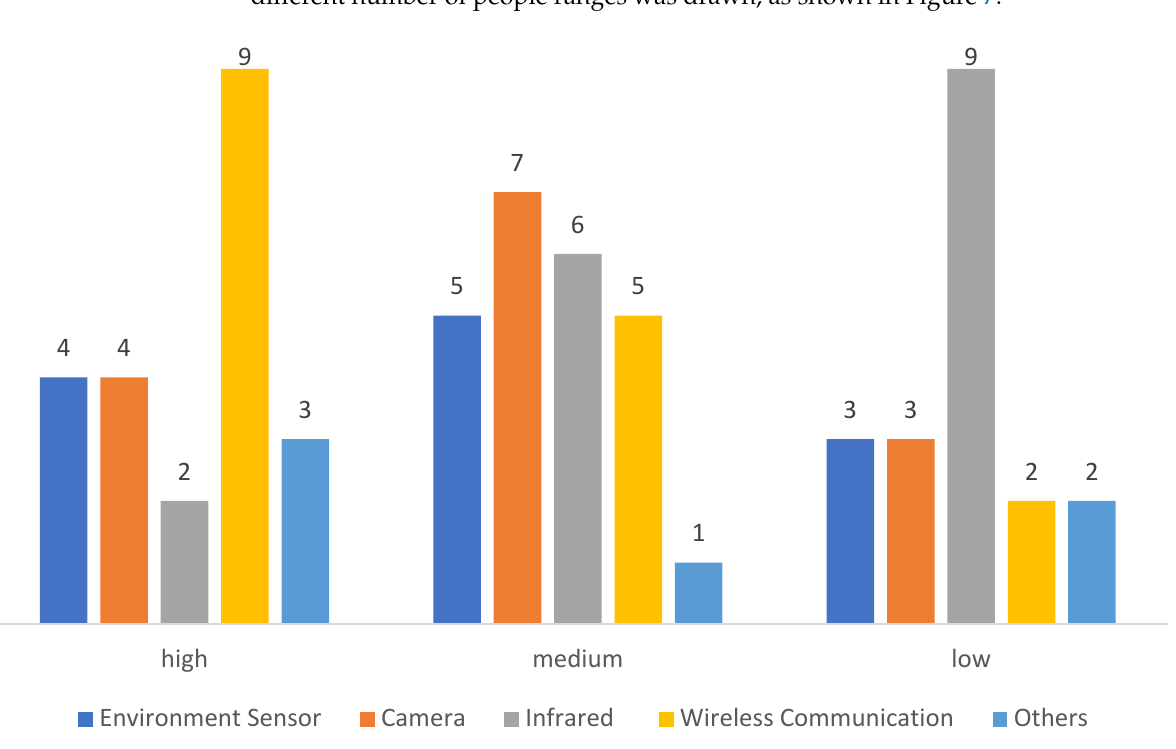
Figure 7. The number of occupancy measurement systems used in experiments with different people ranges.